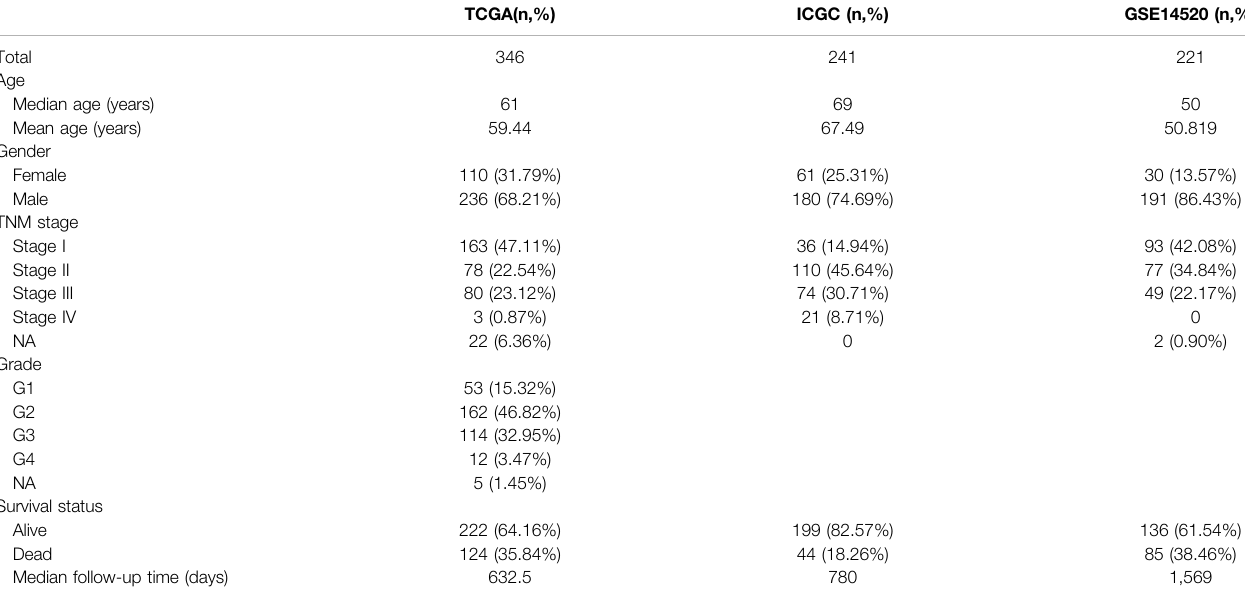
TABLE1 | Clinical and pathologic factors of the datasets used in this